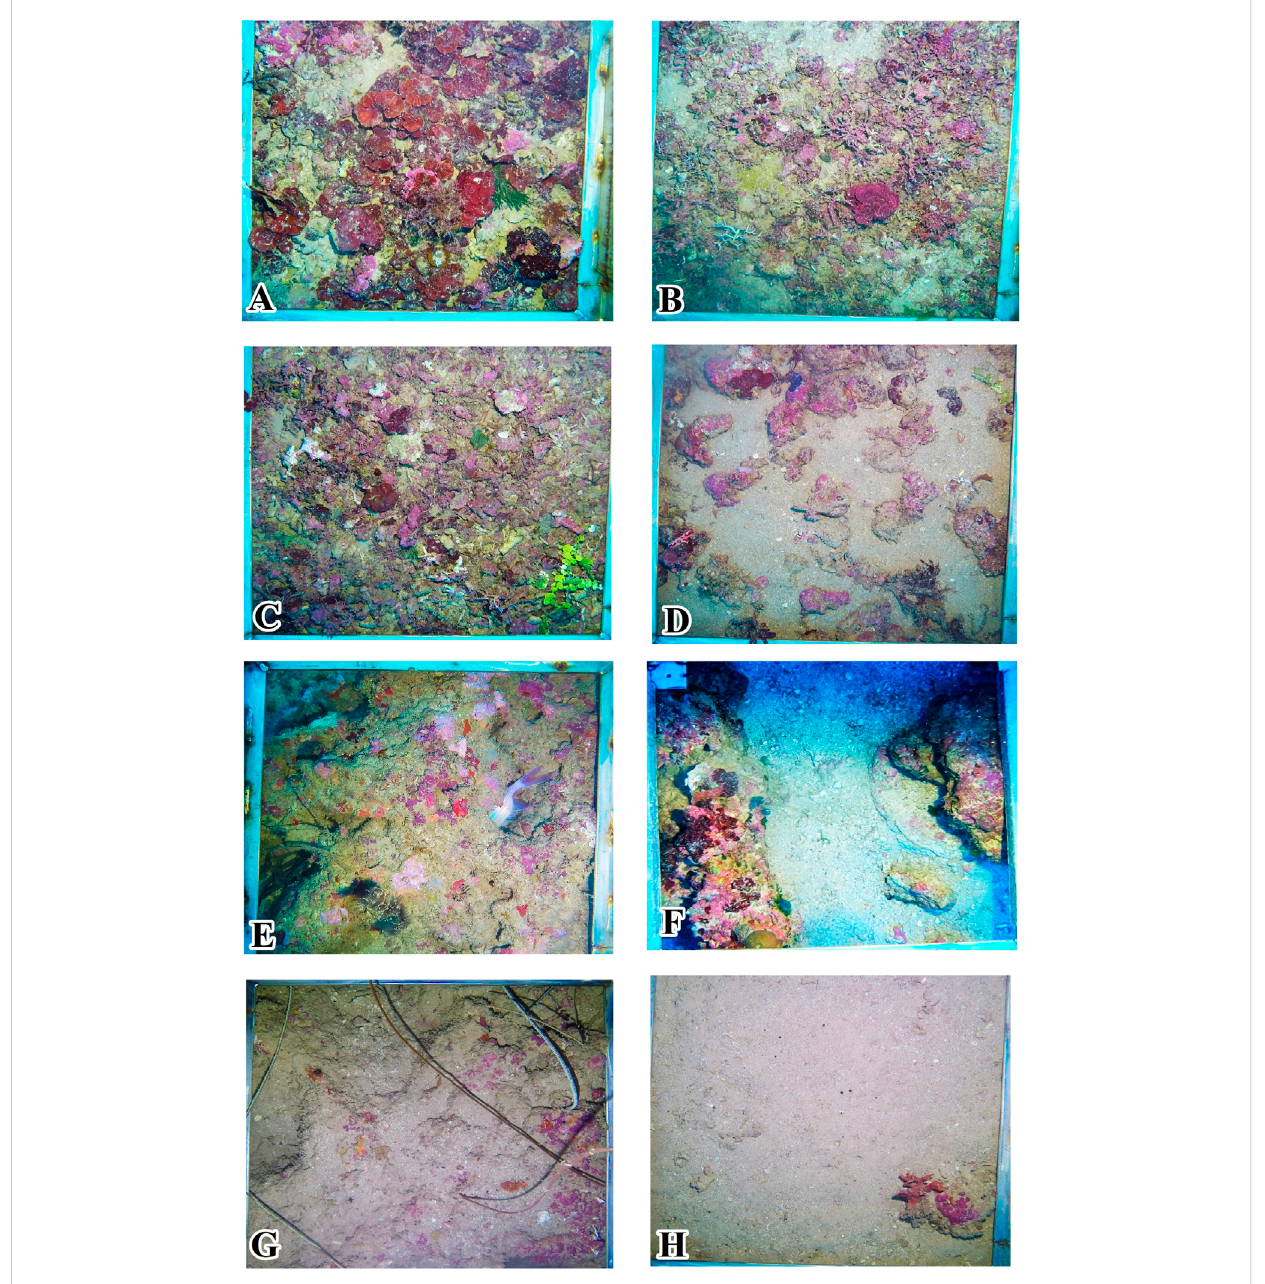
FIGURE 5 Examples of organisms found in the MPA Costa das Algas: (A) Valley fl anks covered by sponges, bio fi lm, and black corals; (B) Bryozoans and sea squirts; (C) Rhodoliths covered by Peyssonnelia sp. (red algae); (D) Sponges and bio fi lm on valley fl ank; (E) Rhodoliths and Codium sp. (green algae); (F) GCA, green algae and sea urchin; (G) Bryozoans and sea star; (H) Bio fi lm, CCAs on hardgrounds and black